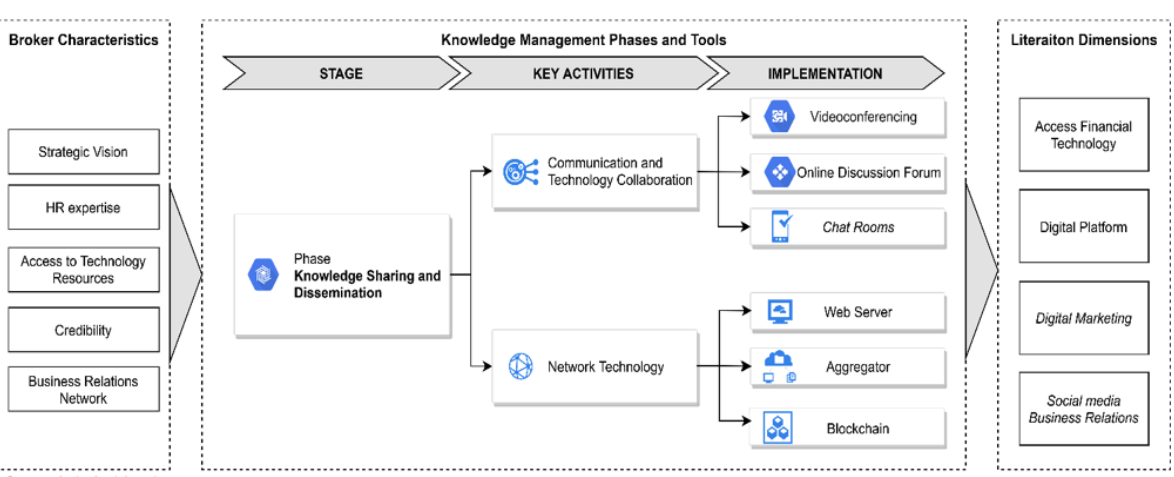
Figure 3: Improving SME Digital Literacy through the process of sharing and disseminating knowledge; Source: Author’s